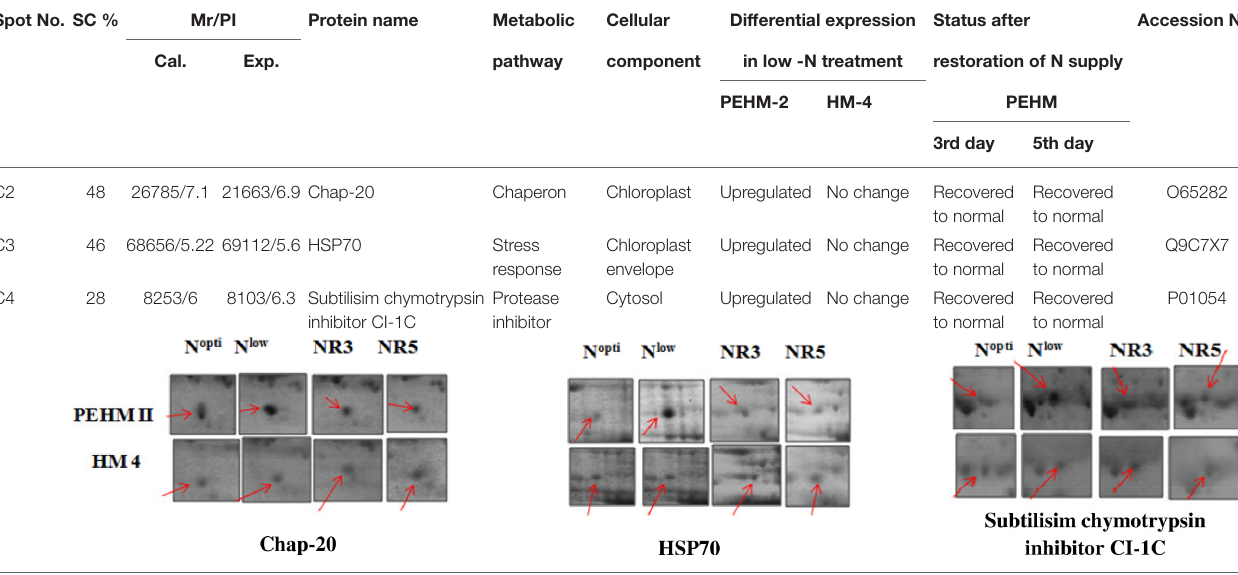
TABLE 4 | Proteins expressed differentially between genotypes and treatments both. Spot No. SC